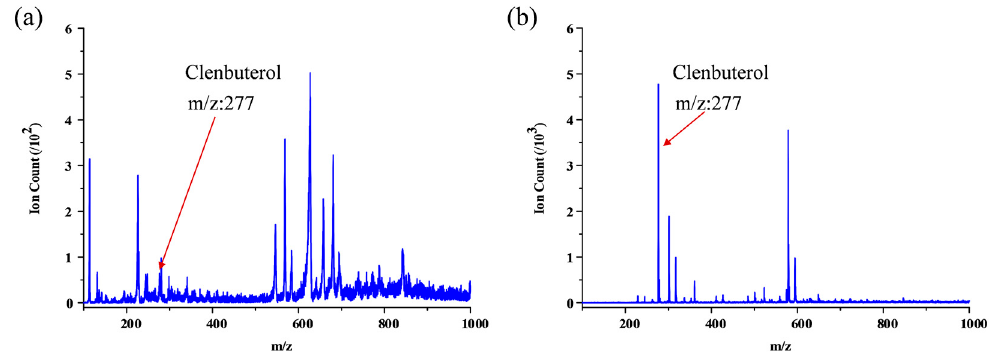
Figure 7. Results of SPME using urine sample spiked with 3.2 µM clenbuterol hydrochloride: ( a ) Direct ESI using a commercial capillary and ( b ) On-chip SPME and ESI using optimal chip configuration.